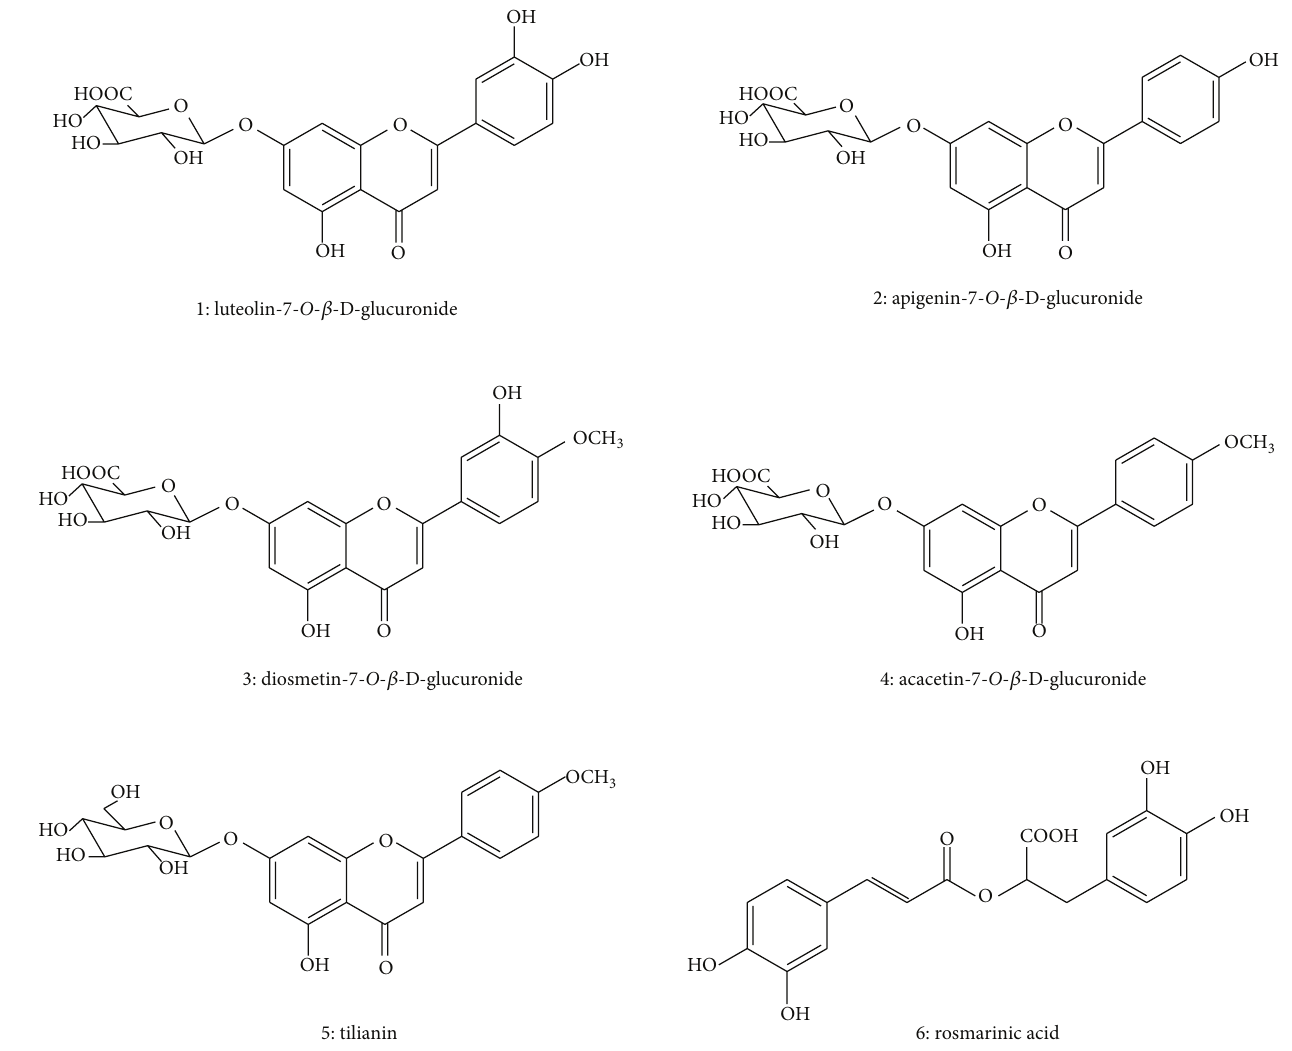
Figure 1: Chemical structures of six active